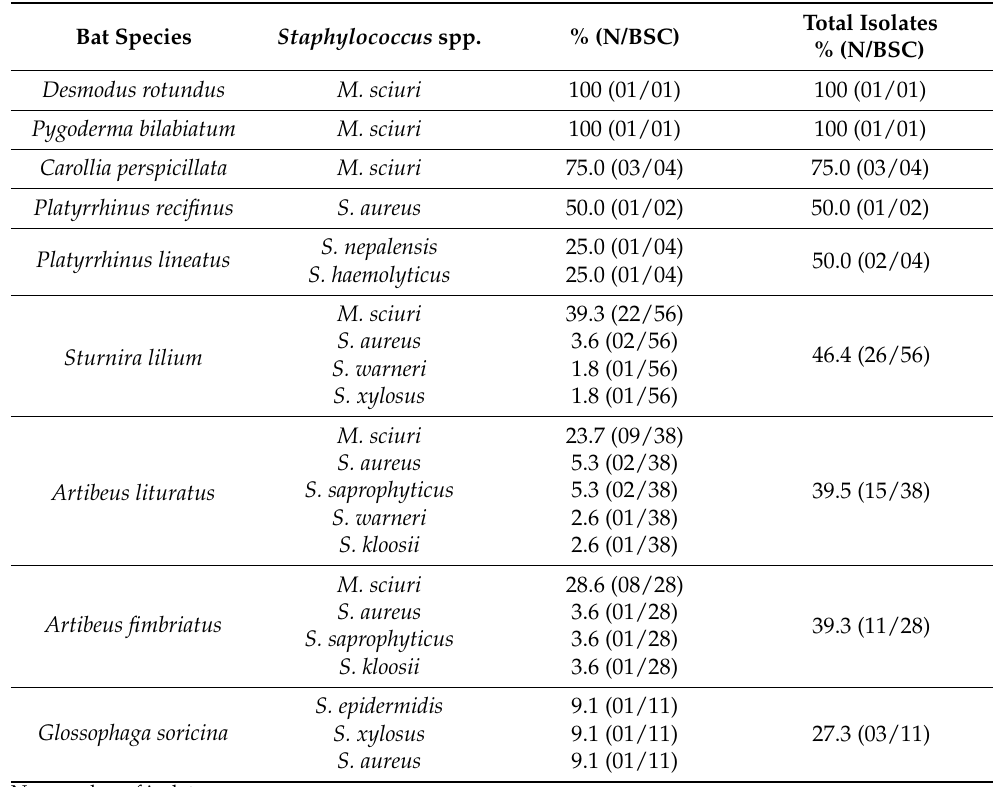
Table 1. Frequency of the ten Staphylococcaceae species isolated from skin swab samples according to bat species count (BSC). Results are arranged in descending order of the total number of